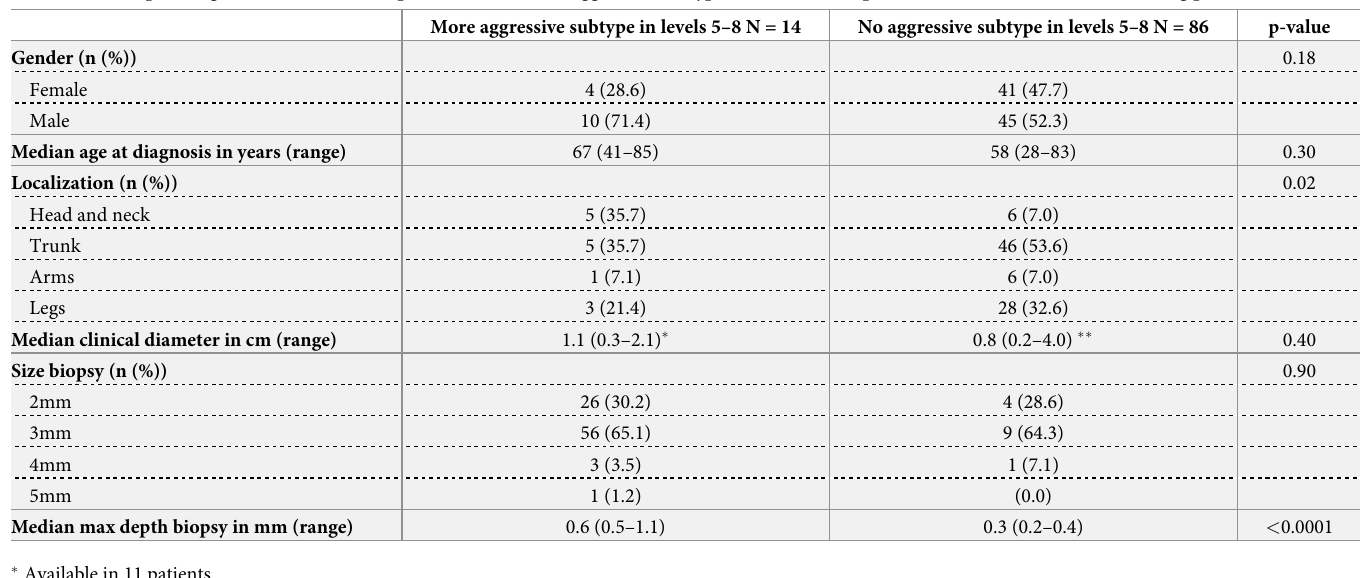
Table 2. Clinicopathological characteristics of patients with a more aggressive subtype in additional step sections (levels 5–8) vs. the remaining patients. More aggressive subtype in levels 5–8 N =